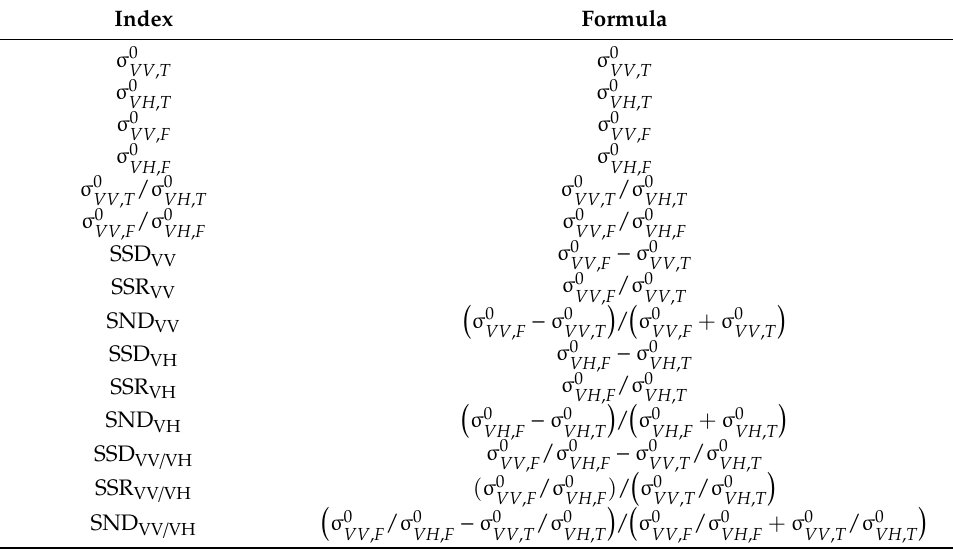
Table 1. Used 15 SAR indices in this